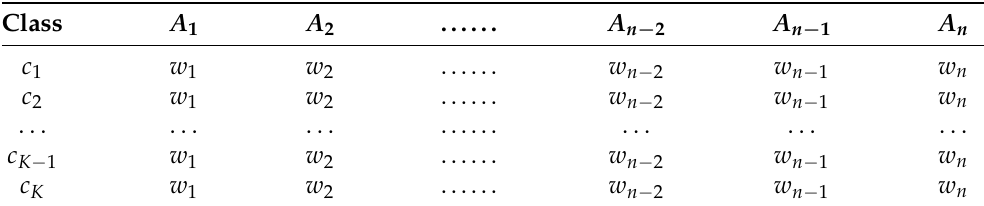
Table 1. The naive Bayes weight